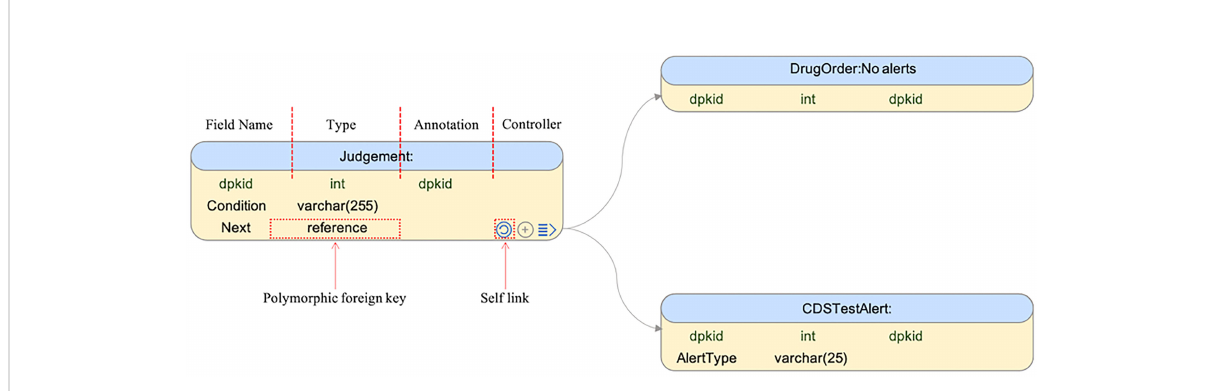
FIGURE 2 Interface of the MMKP schema design. Three knowledge tables abstracted from the decision fl ow are shown, of which the cells from left to right refer to the fi eld name, fi eld type, manual annotation and polymorphic foreign key controller. The Type ‘ Reference ’ indicates that fi eld ‘ Next ’ is a polymorphic foreign key. The Controller button from left to right adds the polymorphic foreign key link to its main table, to a new table, or shows the already-linked tables in the working canvas.